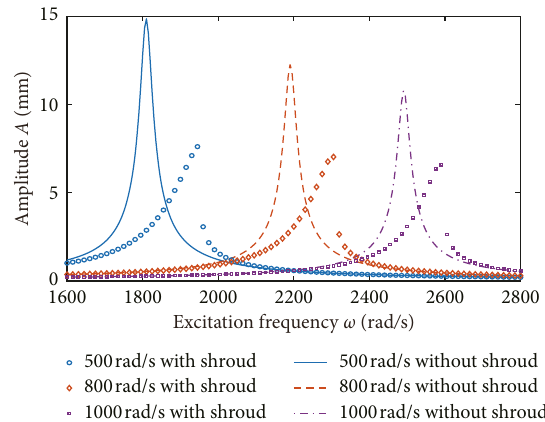
Figure 4: The amplitude-frequency curves at different rotational